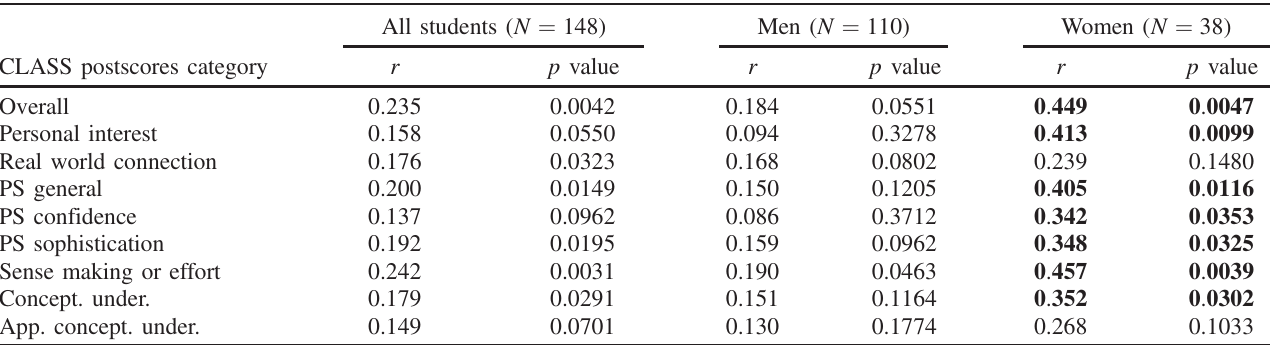
TABLE VIII. Correlation of the normalized FCI gain and CLASS postscores, separated by category, for all students, men, and women. The regression coefficient r and the p value are given.